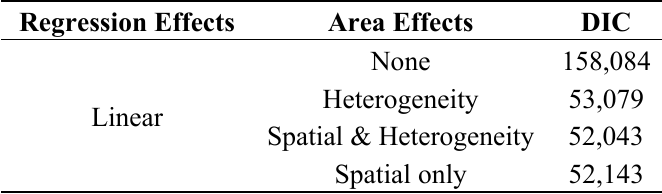
Table 5. DIC according to regression type and area effects, self-harm Data